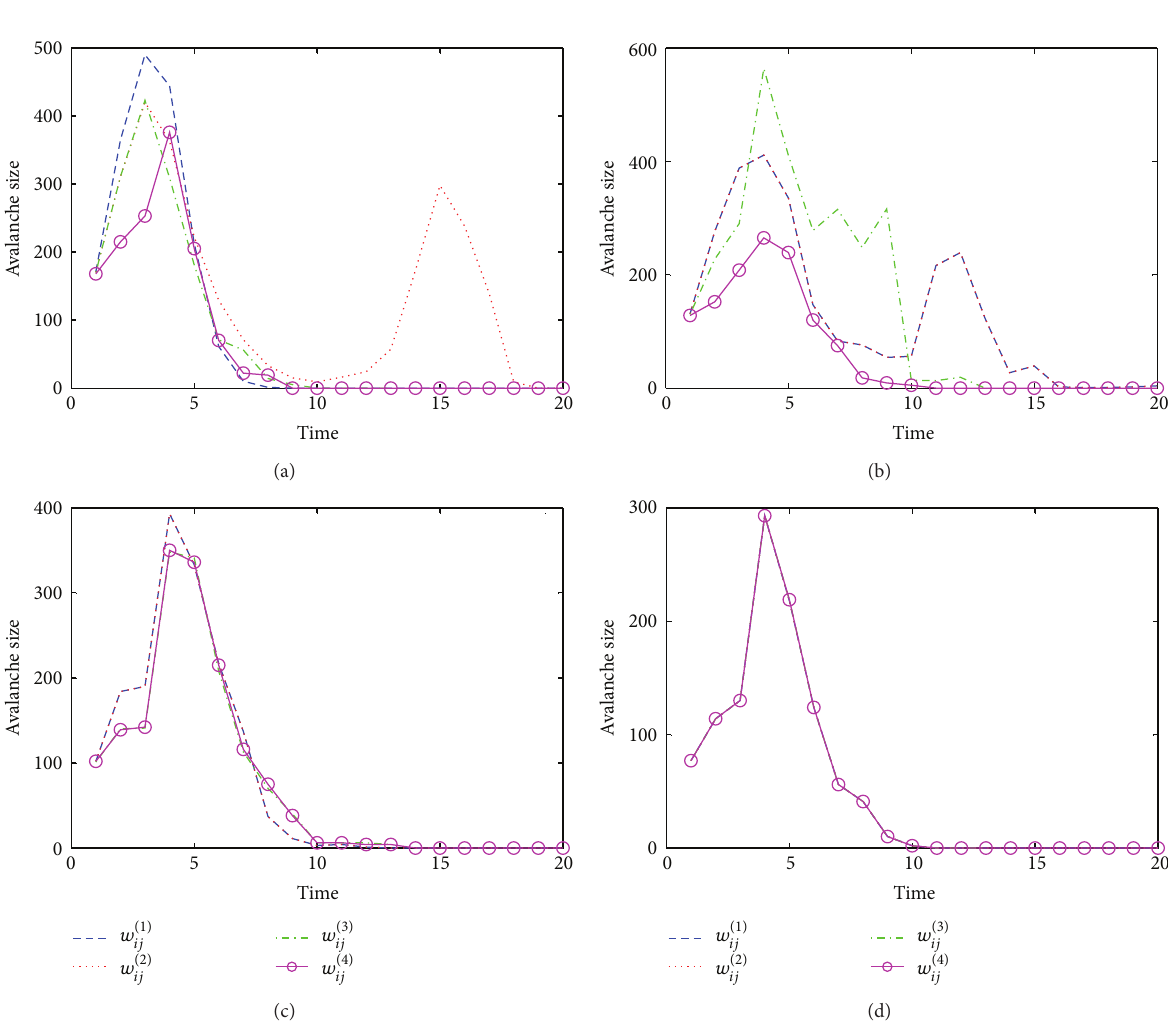
Figure 6: For SF network with 𝜏 = 20 under HL attack, the avalanche size 𝑁 𝛼 = 0.04 , (c) 𝛼 = 0.06 , and (d) 𝛼 = 0.08 ,